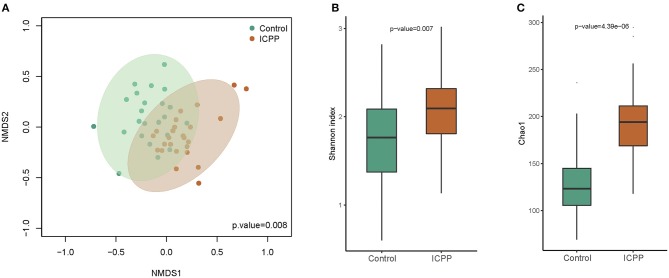
Non-metric multidimensional scaling (NMDS) distribution and microbiota diversity in ICPP and Control group. (A) NMDS analysis, the samples from ICPP group was clustered together, and they are separated from those of the Control group. (B) The diversity in the bacteria community was significant lower in the Control group than that in the Case group (P < 0.01). (C) The Chao indexed of gut microbiota was obviously lower in Control group than that in ICPP group (P < 0.01).